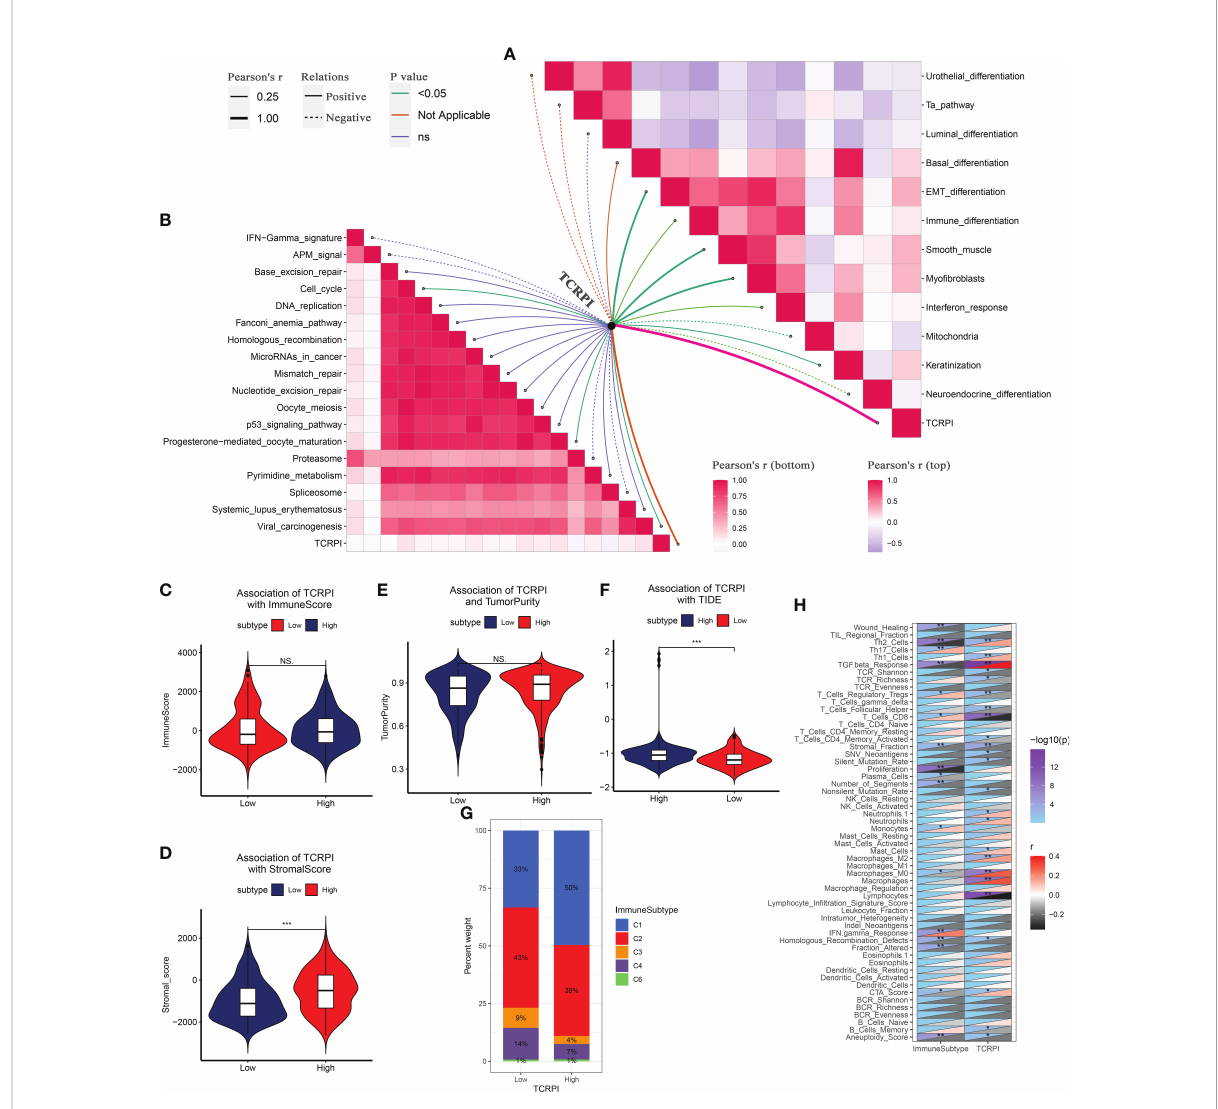
FIGURE 5 Correlation of TCRPI with bladder cancer-related pathways and immune-related features. (A) Association of TCRPI with bladder cancer related pathways. (B) Association of TCRPI with immunotherapy response related pathways. (C) Association of TCRPI with immune score. (D) Association of TCRPI with stromal score. (E) Association of TCRPI with tumor purity. (F) Association of TCRPI with TIDE. (G) Association of TCRPI with immune subtypes. (H) Association of TCRPI with 56 molecular signatures. NS, no signi fi cance, *P <0.05, **P <0.01, ***P